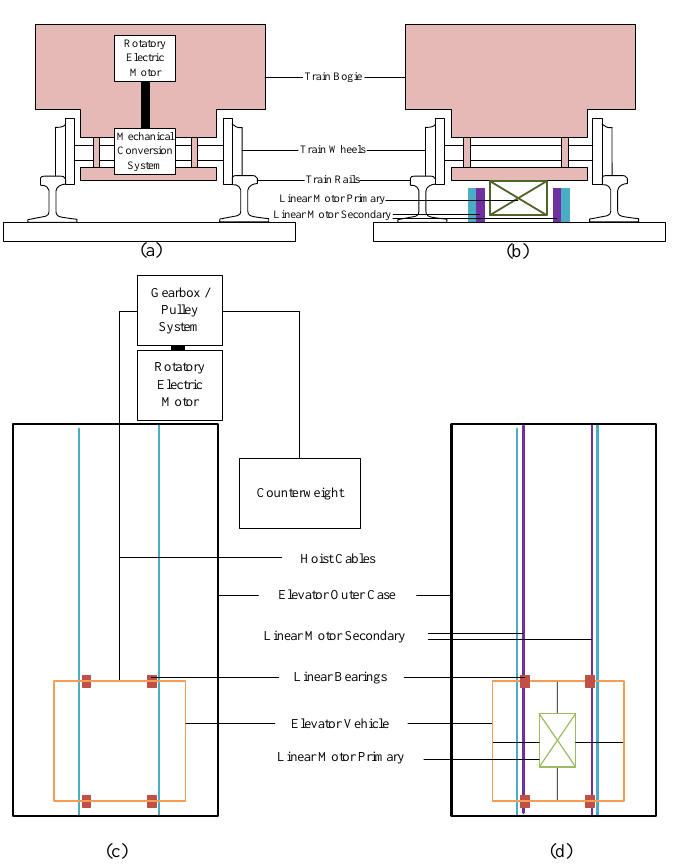
Figure 1. Existing and proposed schemes of targeted applications: ( a ) existing electric train, ( b ) proposed electric train, ( c ) existing vertical lifting, and ( d ) proposed rope-less